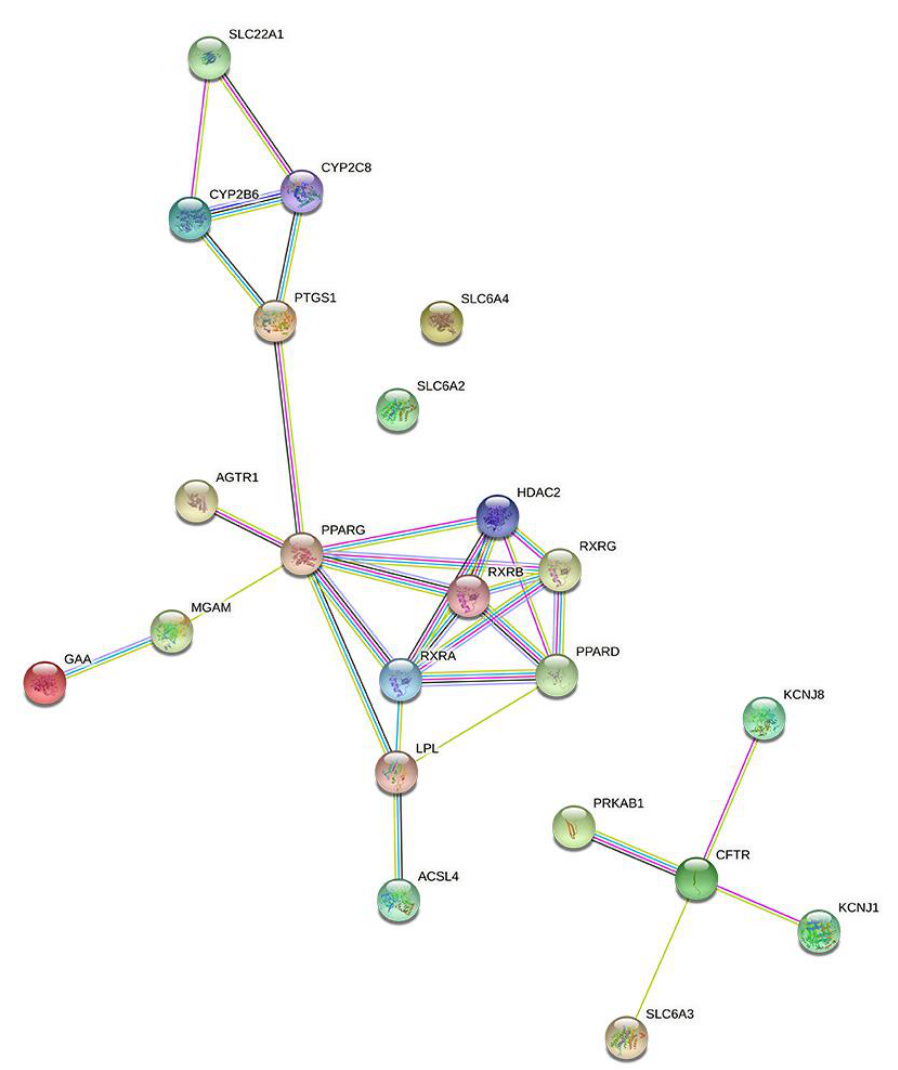
Figure 1. The interaction network relationships between targets (each node represents a target and each edge represents the proteins that jointly contribute to a shared function).